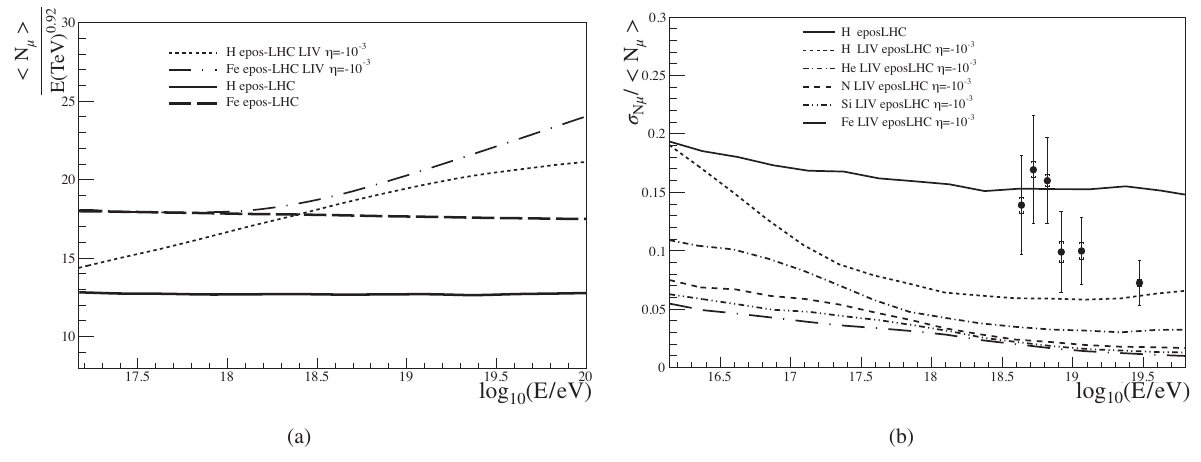
Figure 5. (a) Average number of muons at ground vs primary energy in LI and LIV cases; (b) Data (black points with error bars) compared to LI and LIV models for the relative fluctuation of the number of muons vs primary energy. The LIV case corresponds to η = − 10 − 3 . The statistical uncertainty is indicated by the error bars. The total systematic uncertainty is indicated by the square brackets. Figures from